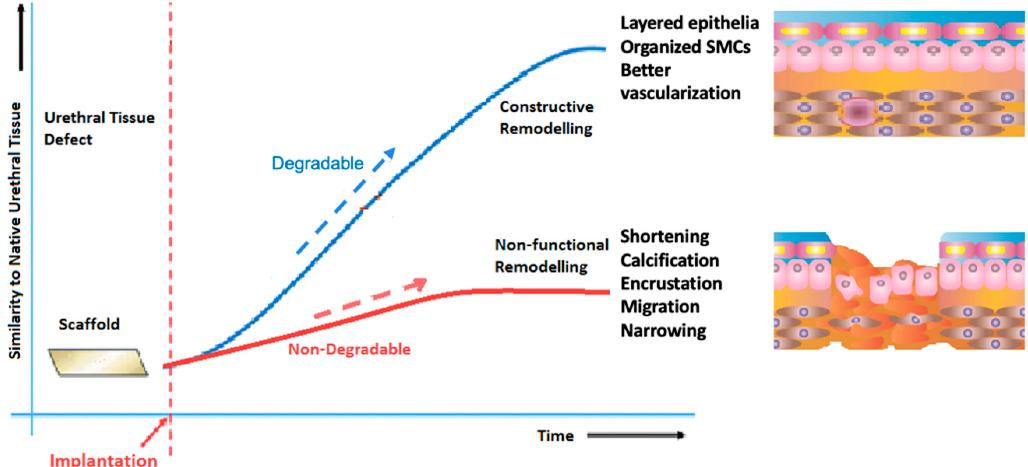
Figure 2. Schematic representation of the advantages of scaffold degradability with regards to restoration of “healthier” tissue engineered urethral replacement. Non-degradable biocompatible scaffolds have lead to several undesirable outcomes like shortenig of the implant, calcification, and narrowing of the urethra, collectively kown as “non-functional remodeling”. On the other hand, resulting regrown tissues following implantation of optimized degradable constructs has lead to “constructive remodeling” with the resulting tissues closer to the native normal urethra.